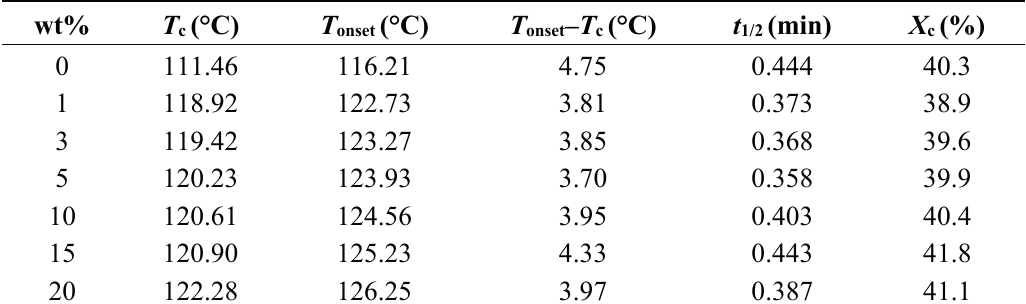
Table 2. Crystallization properties of PP/CF